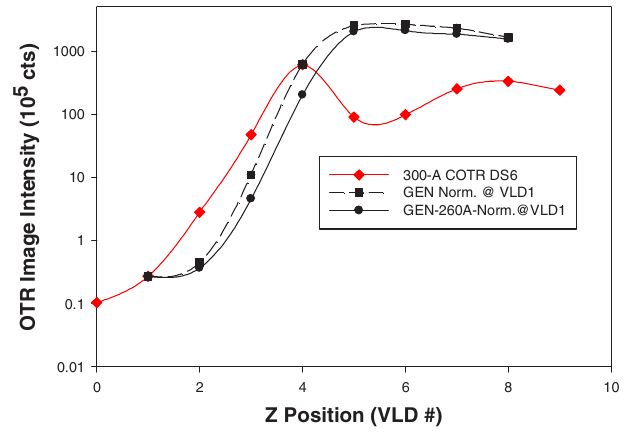
FIG. 12. (Color) The z -dependent COTR gain curve for SASE- induced microbunching at the FEL fundamental wavelength of 530 nm on December 20, 2001 (diamonds) and for recent GENESIS simulations of the microbunching fraction squared for the 300-A case (squares) and the 260-A case